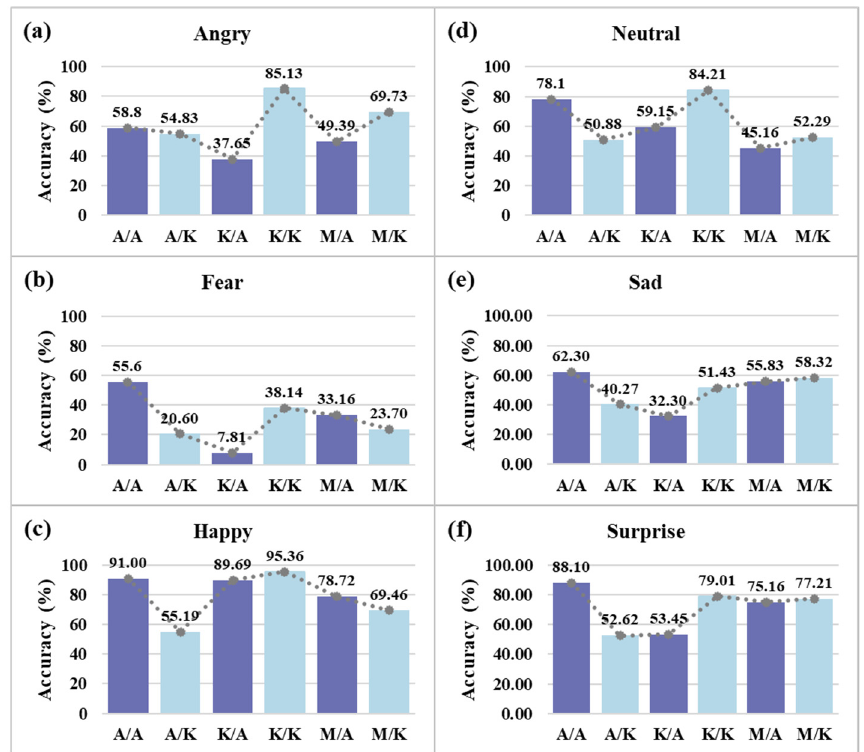
Figure 6. SE-ResNeXt50 (32 × 4 d)’s accuracy according to different emotions: ( a ) angry, ( b ) fear, ( c ) happy, ( d ) neutral, ( e ) sad, ( f ) surprise.